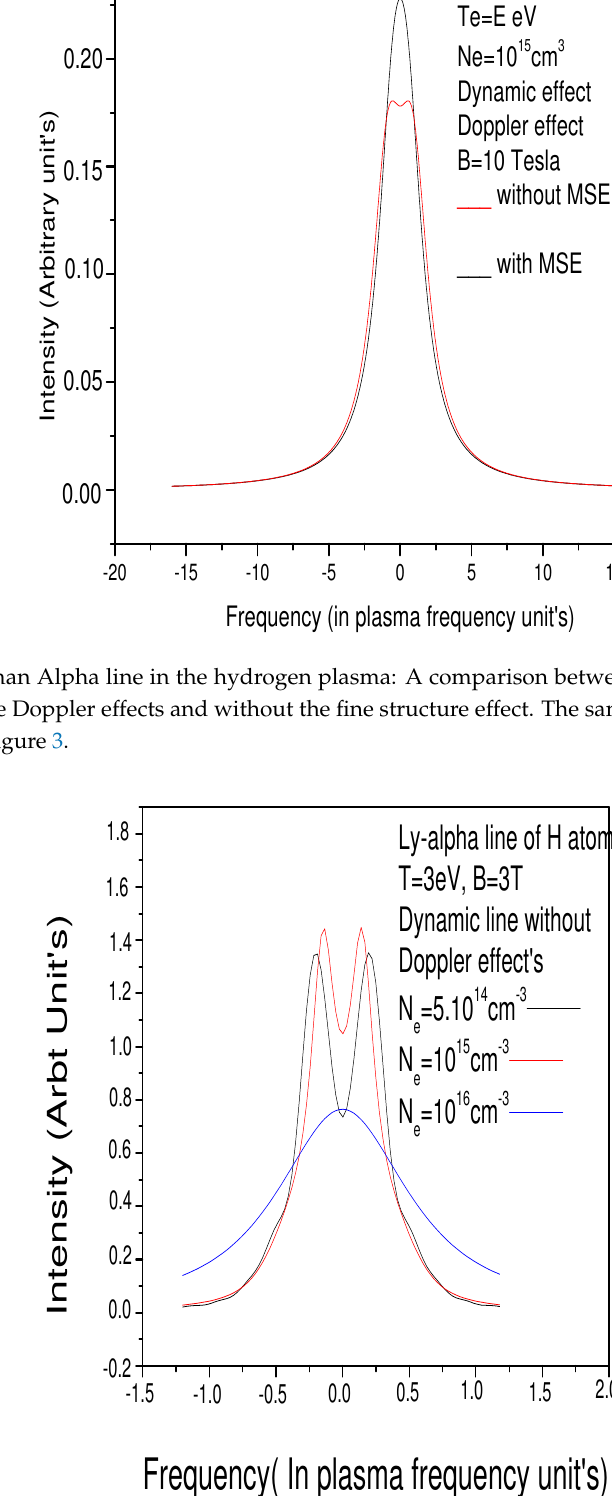
Figure 5. Lyman Alpha line in the hydrogen plasma: The electron density effect with the MSE effect and without Doppler and fine structure